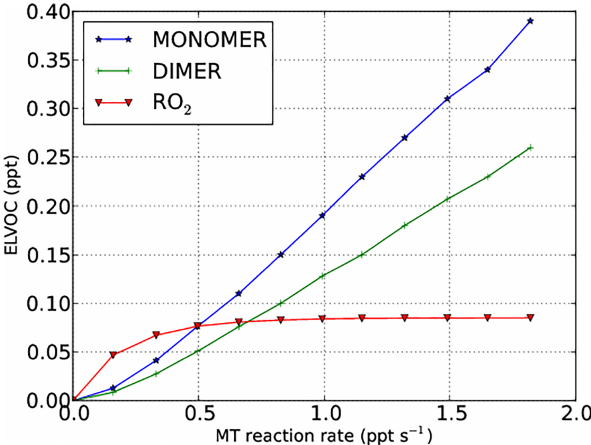
Figure A1. ELVOC concentrations as a function of the α -pinene reaction rate for the low-NO x experiment.